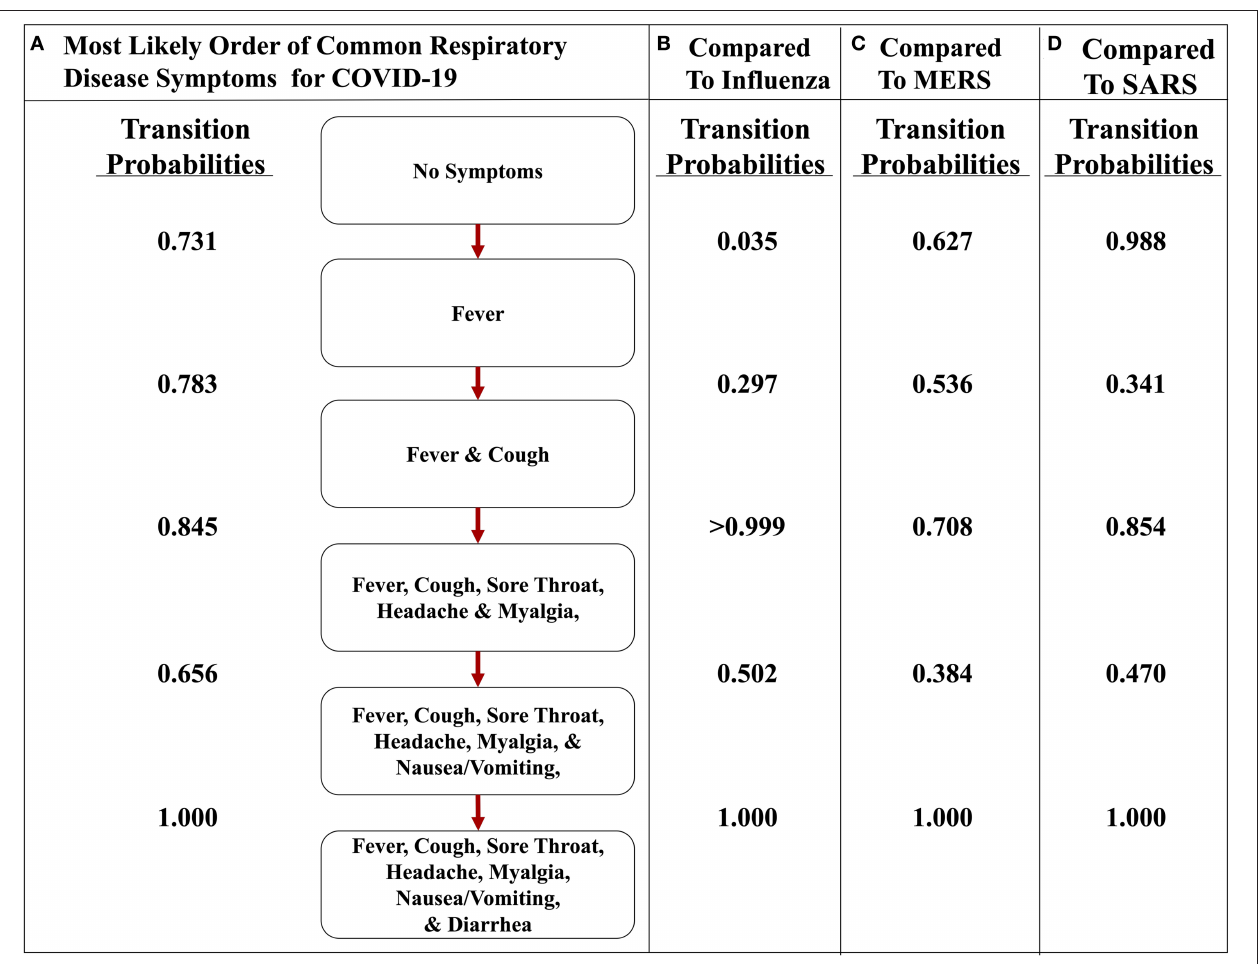
FIGURE 6 | The most likely path of symptoms in COVID-19 vs. influenza, MERS, and SARS. (A) The most likely path of seven common symptoms of COVID-19 with the transition probabilities listed between nodes. (B) The transition probabilities of the path of influenza. (C) The transition probabilities of the path of MERS. (D) The transition probabilities of the path of SARS. The most likely path here is determined from the transition probabilities listed between nodes for